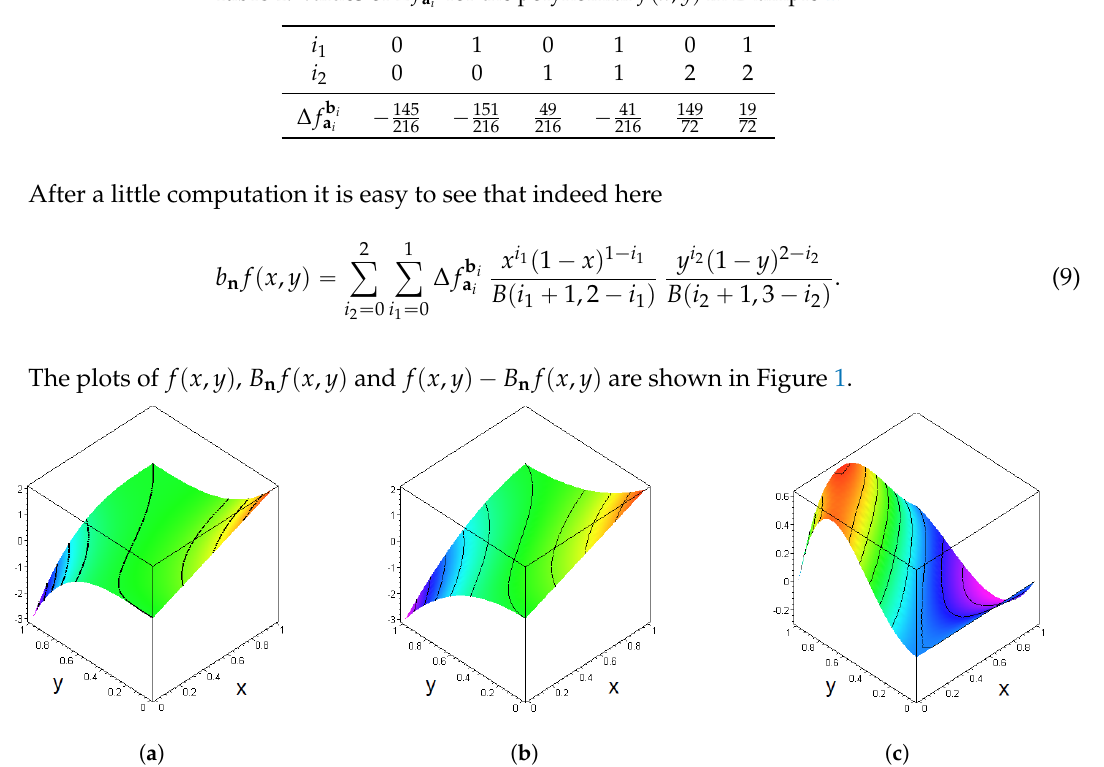
. ( c ) Plot of x , y p q